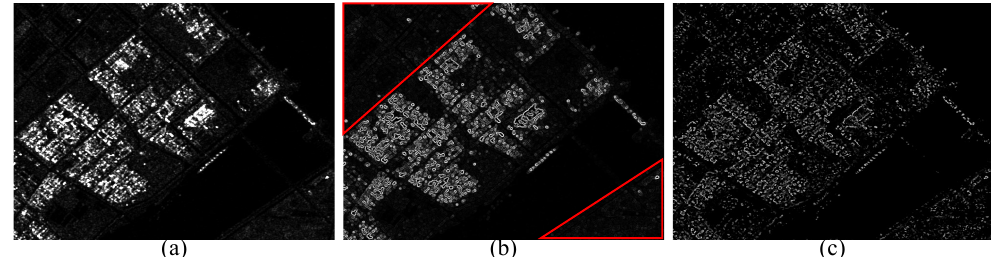
Figure 4. Comparison of phase congruency and gradient. ( a ) SAR image. ( b ) Gradient feature. ( c ) Phase congruency